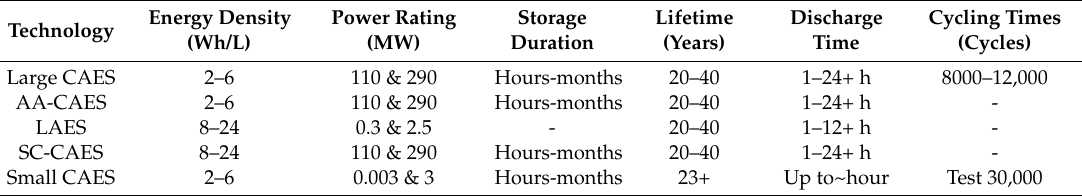
Table 3. Comparison of various CAES technologies